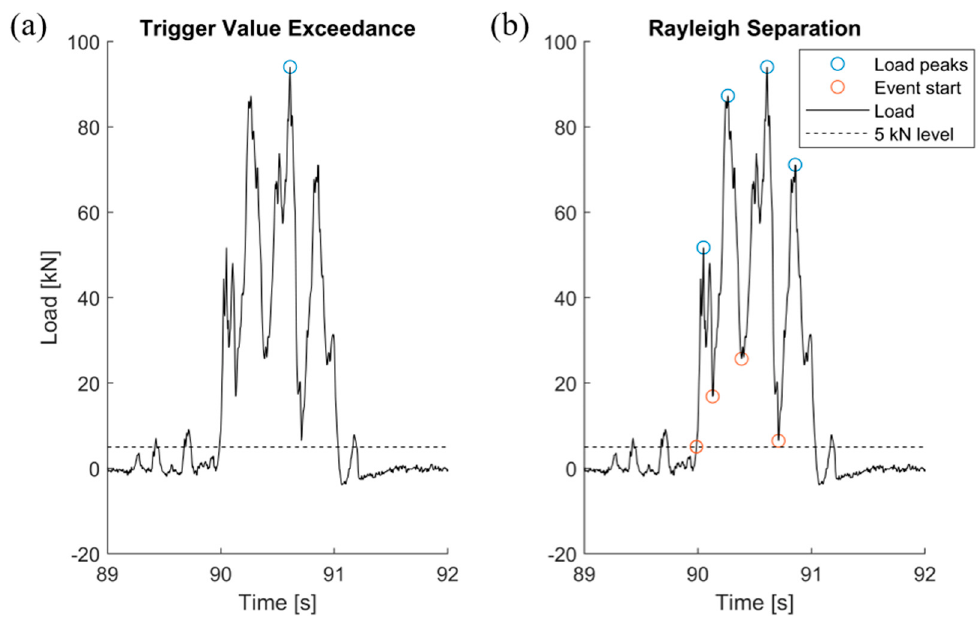
Figure 4. ( a ) Load event identified and separated with Rayleigh separation and ( b ) load identified with trigger value exceedance on the right.